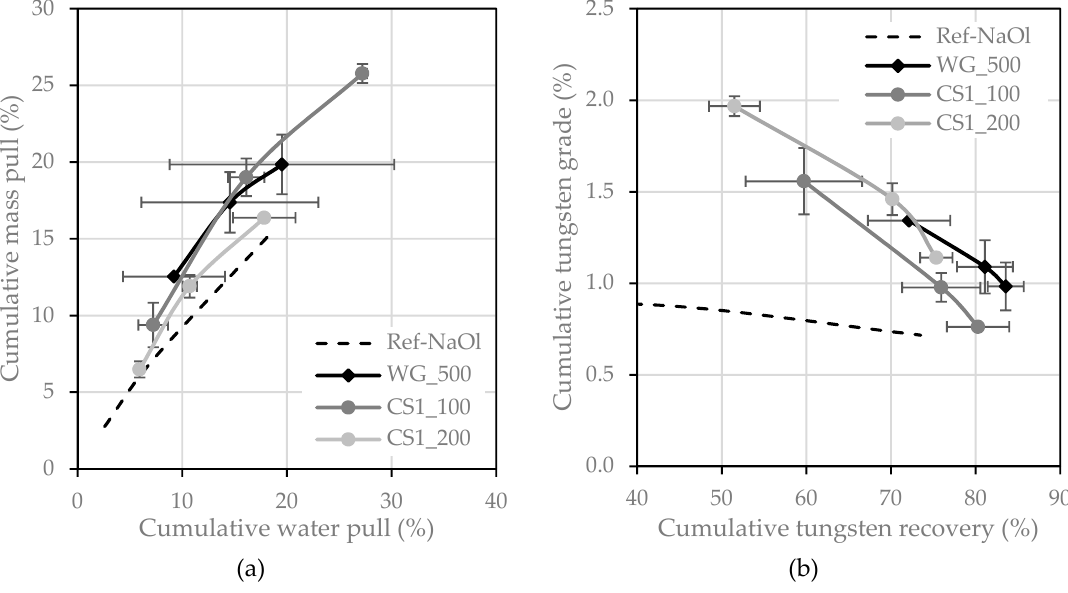
Figure 6. ( a ) Mass pull against water pull and ( b ) cumulative tungsten grade against recovery (error bars represent the 95% confidence interval).